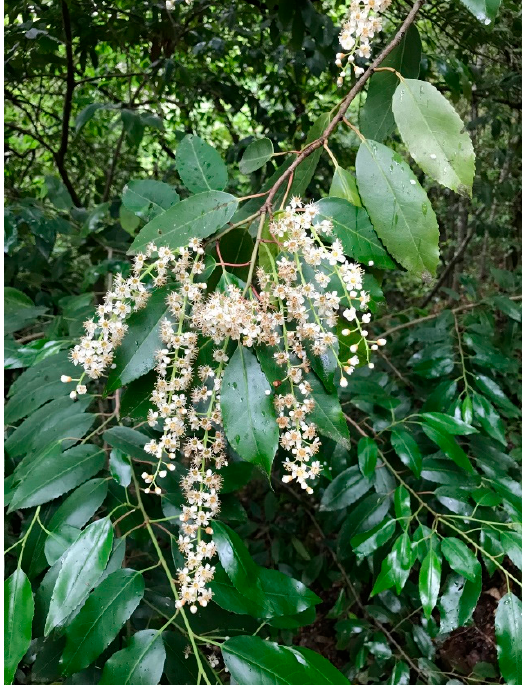
Figure 2. Prunus lusitanica from Margaraça (Arganil, central Portugal).